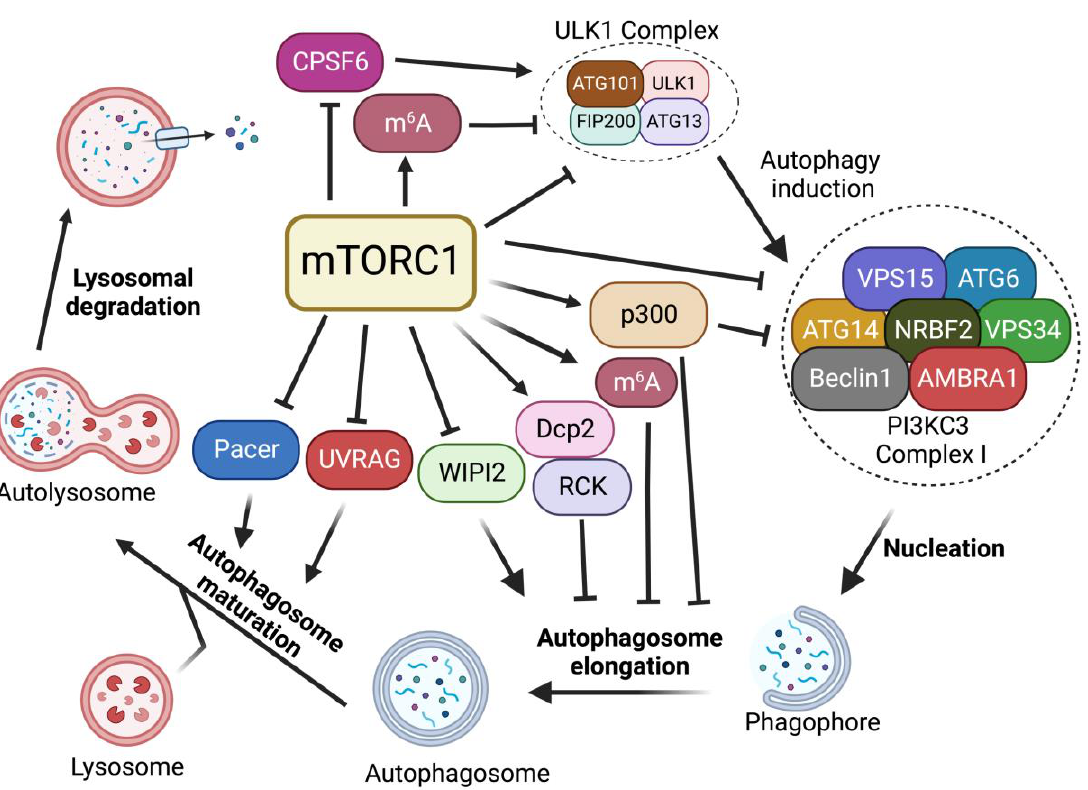
Figure 2. Regulation of autophagy by mTORC1. mTORC1 plays critical roles in the regulation of each step of the autophagy procedure, including autophagy initiation, nucleation, membrane expansion, and termination.